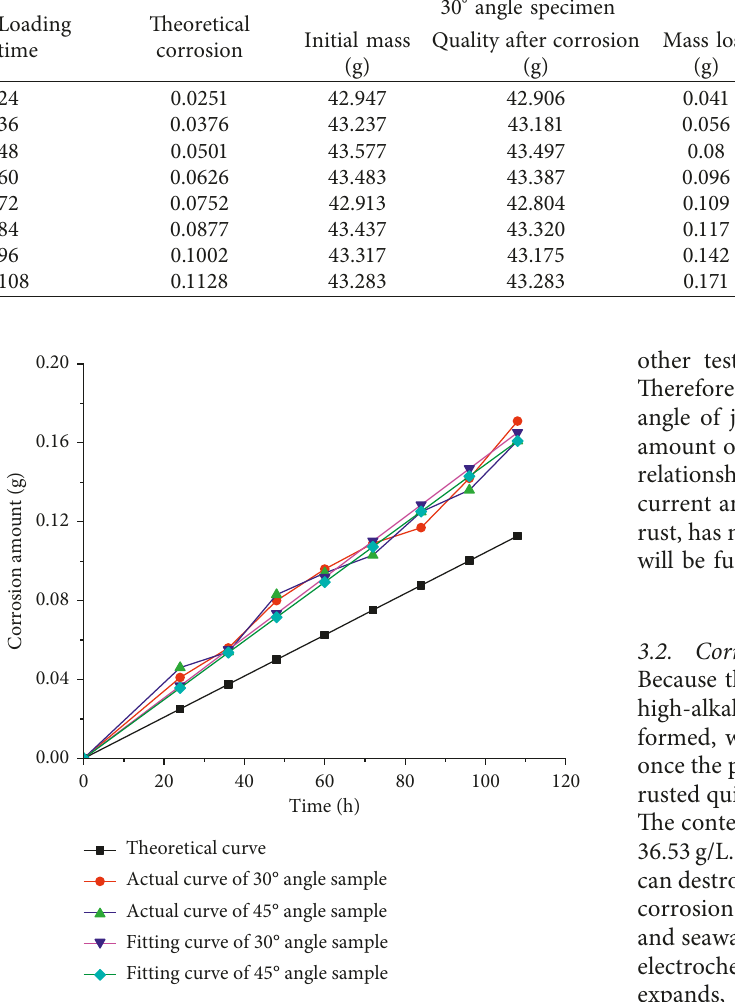
Figure 5: Contrast diagram of fitting curves of 30 ° and 45 ° fracture angle.